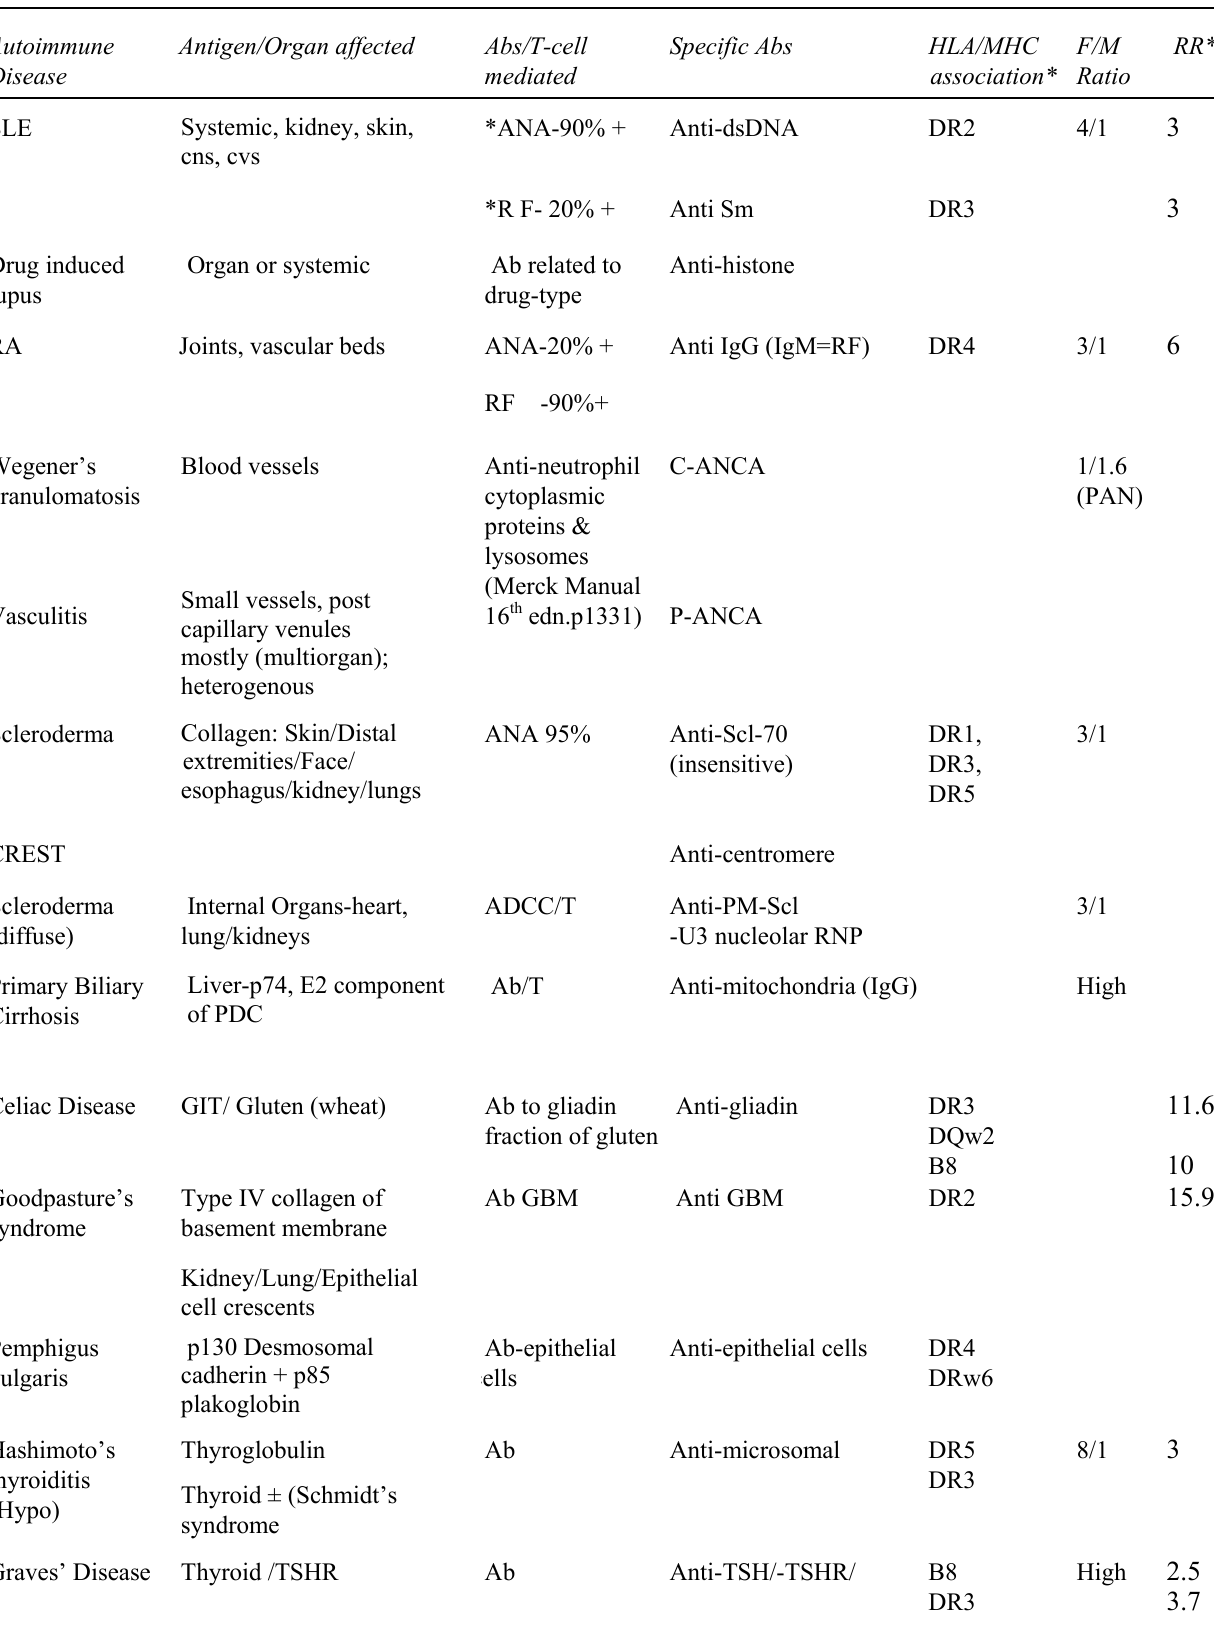
Table 1 : Array of autoantibodies and organs affected Autoimmune